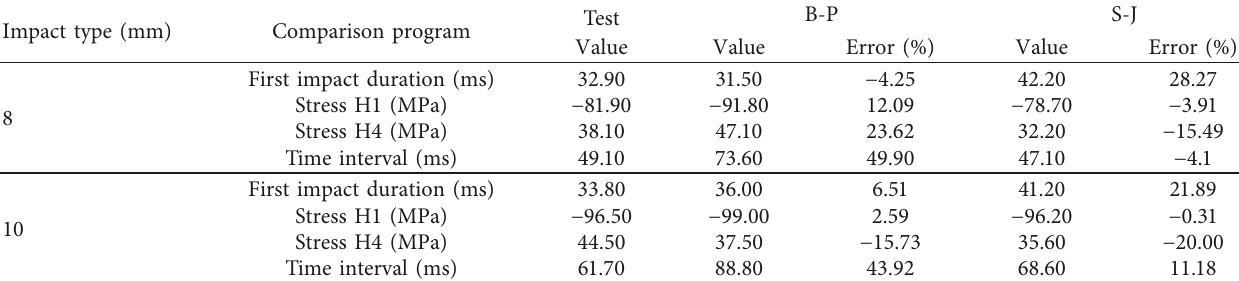
Table 2: Deviation between numerical and test results without roof sheathing.